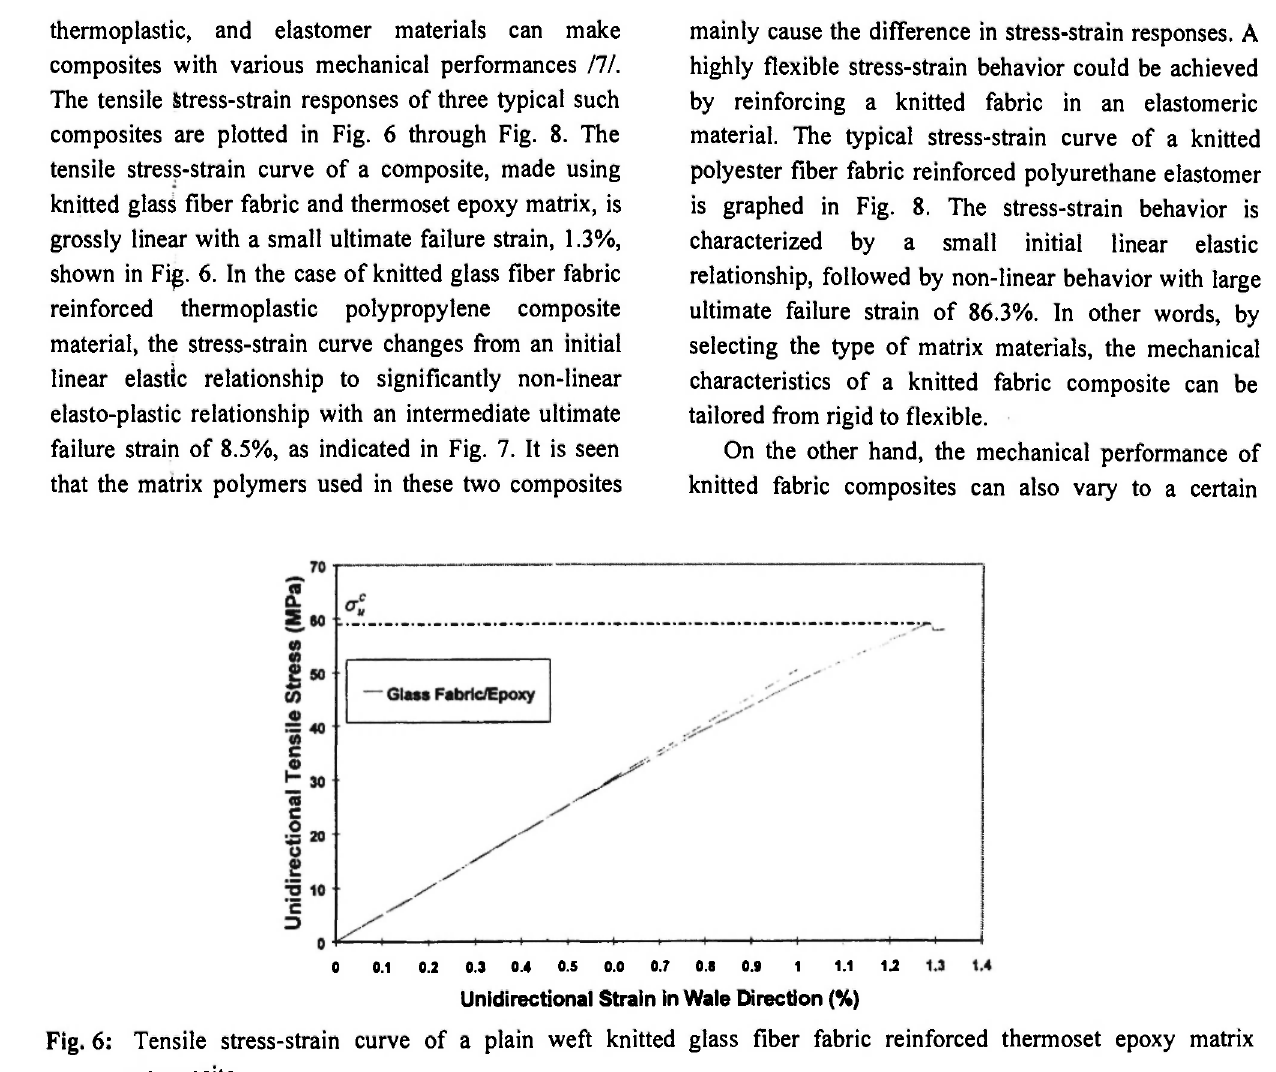
Fig. 6: Tensile stress-strain curve of a plain weft knitted glass fiber fabric reinforced thermoset epoxy matrix composite.